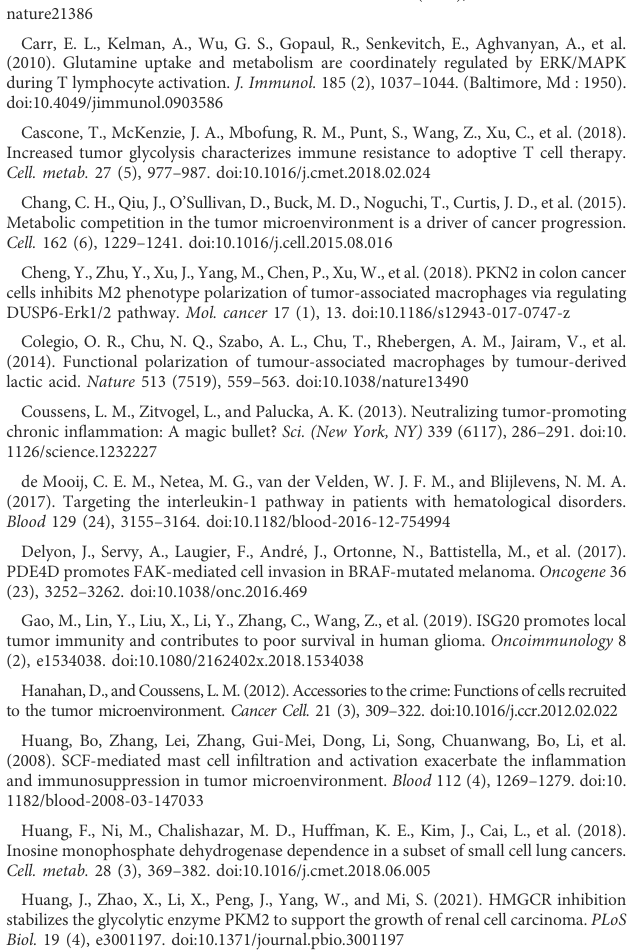
SUPPLEMENTARY FIGURE S1 Results ofunsupervised consensus clustering (A) Consensus matrix legend plot indicating the cluster probability ranging from 0 to 1 with different colors.